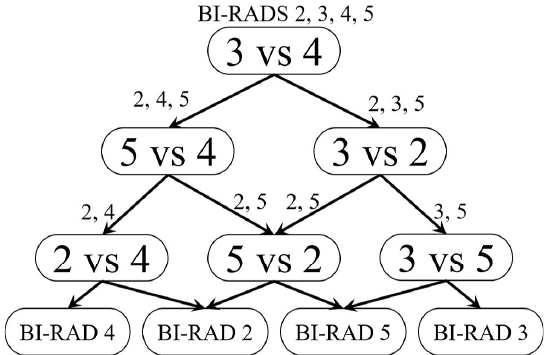
Figure 9. Diagram of the proposed DAG-SVM architecture.